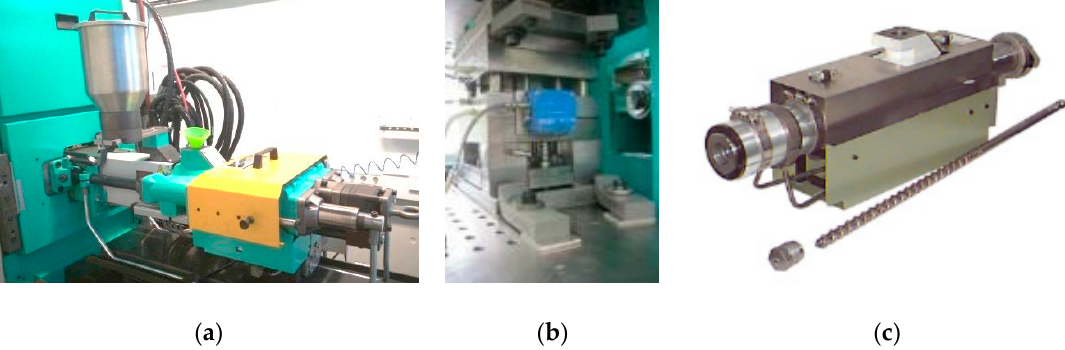
Figure 8. Setup for thermoset injection molding: ( a ) Arburg 375 V injection molding machine, ( b ) closed standard molding tool, and ( c ) attachment for processing of thermosetting plastics.